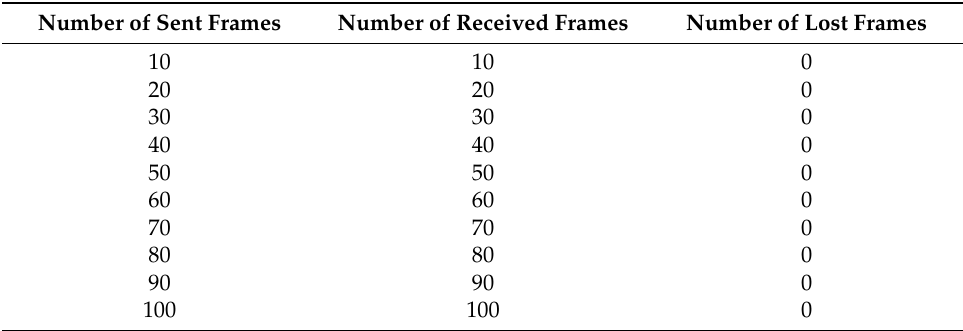
Table 3. The results of Simulation 1.